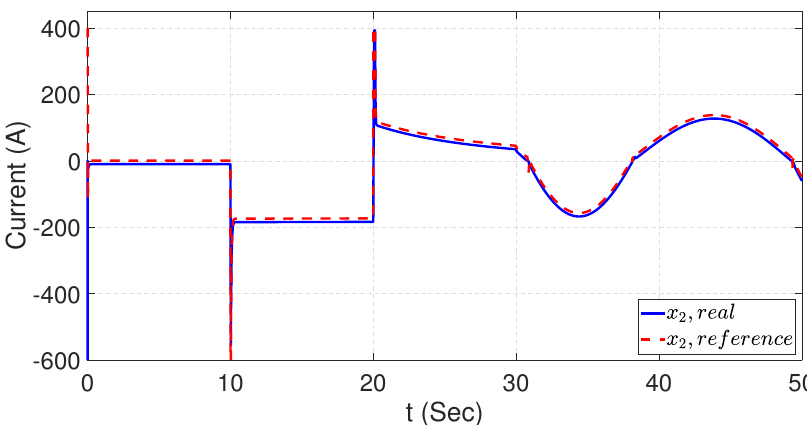
Figure 4. AES current trajectory tracking.